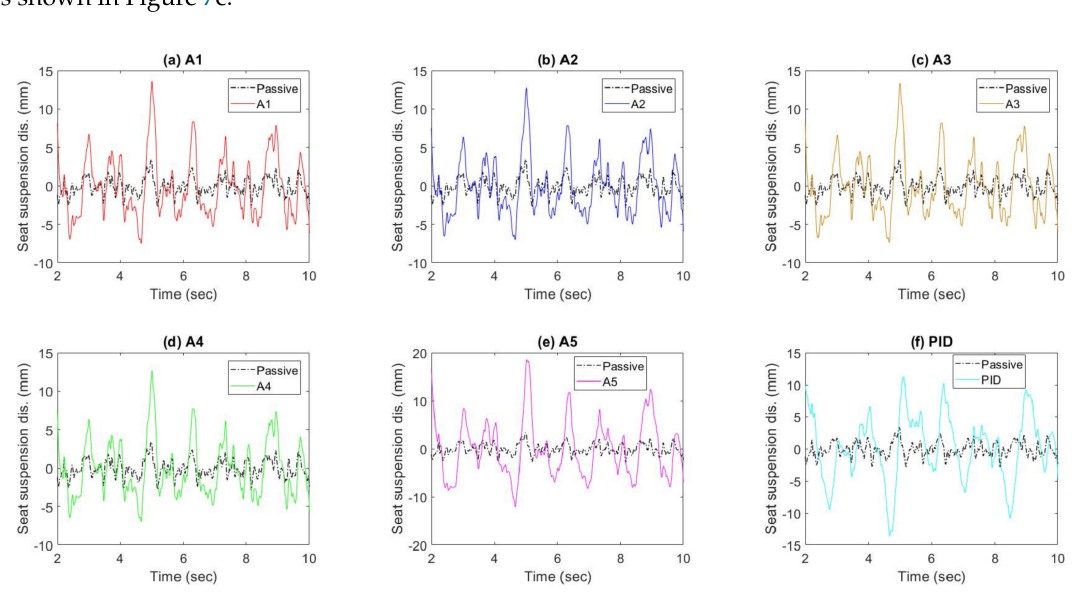
Figure 5. Simulated seat suspension travel of the passive and active seat suspensions at a vehicle speed of 60 km/h. ( a ) A1; ( b ) A2; ( c ) A3; ( d ) A4; ( e ) A5; ( f ) PID.